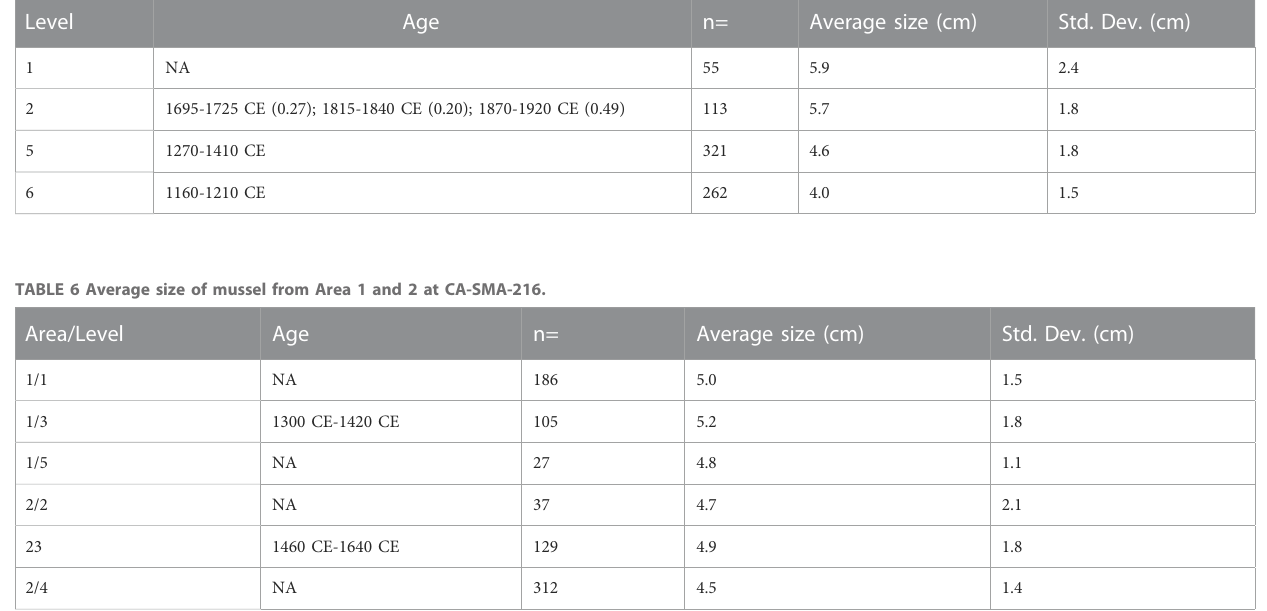
TABLE 5 Average size of mussel from Excavation Unit 2 at CA-SCR-14. Level